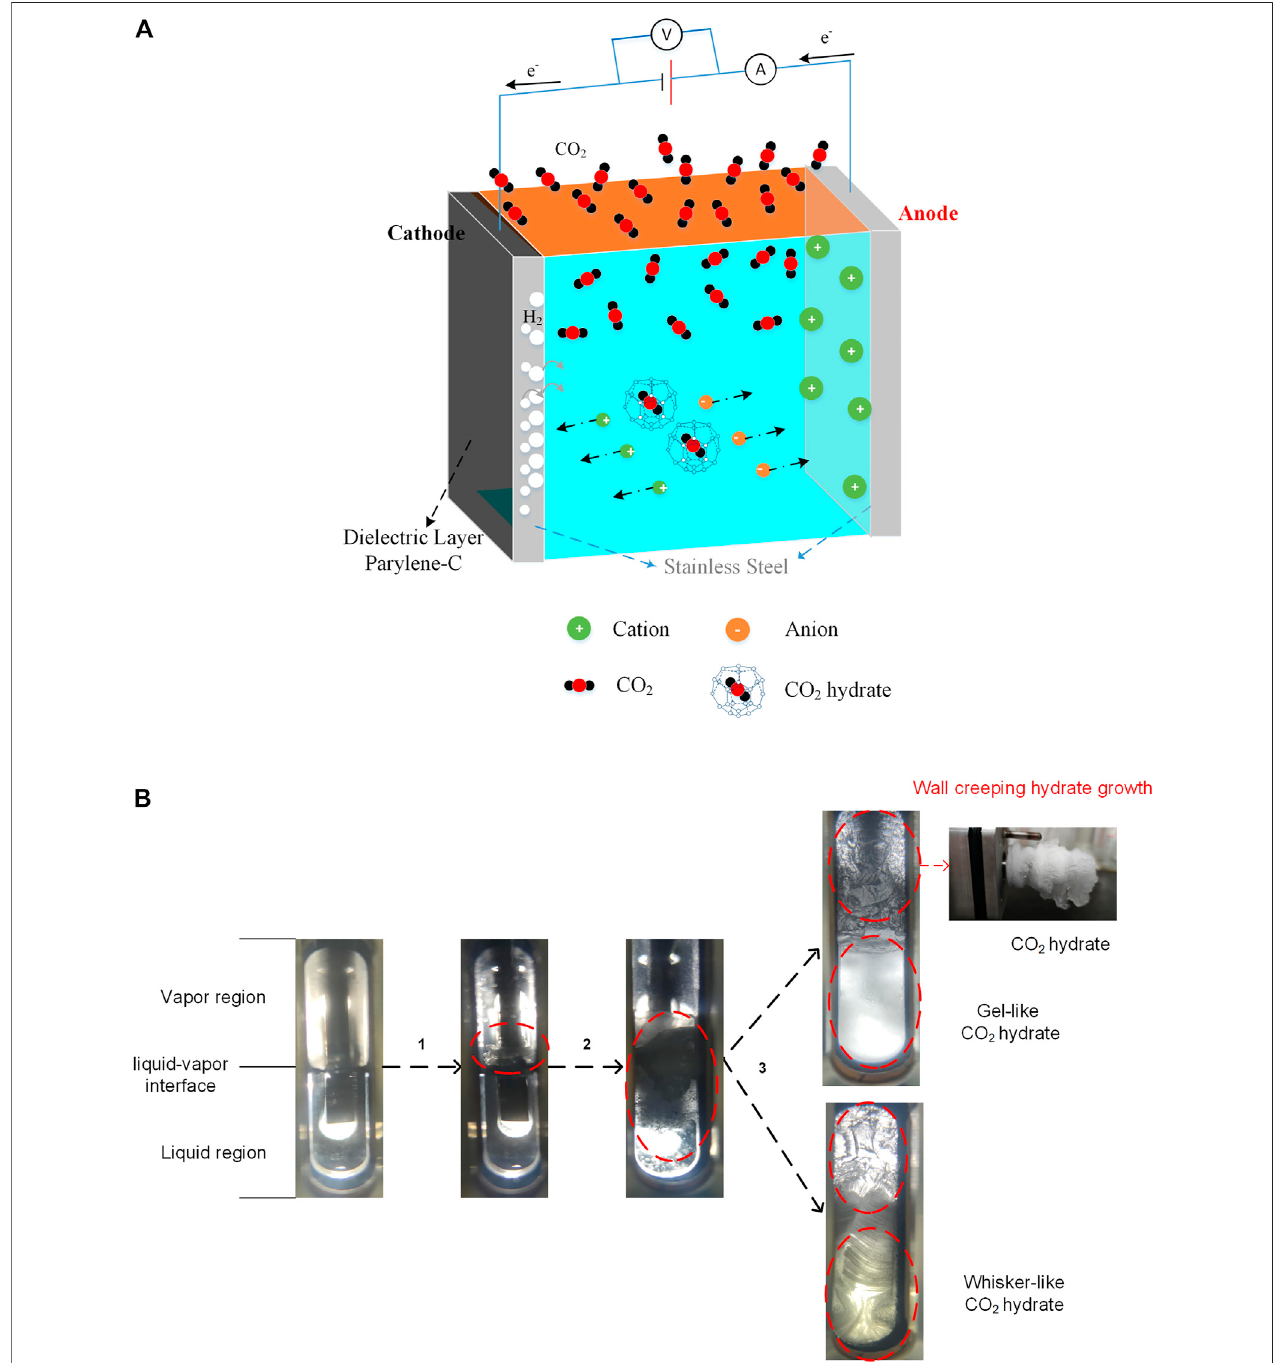
FIGURE 9 | (A) The microscopic schematic diagram of CO 2 hydrate formation in the application of voltages; (B) The formation process of CO 2 hydrate under the action of CF.